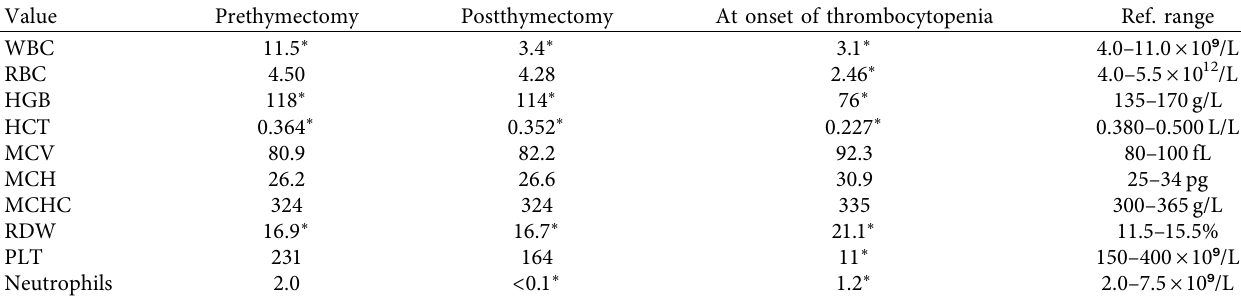
Table 1: Complete blood count values prethymectomy, postthymectomy, and at the onset of